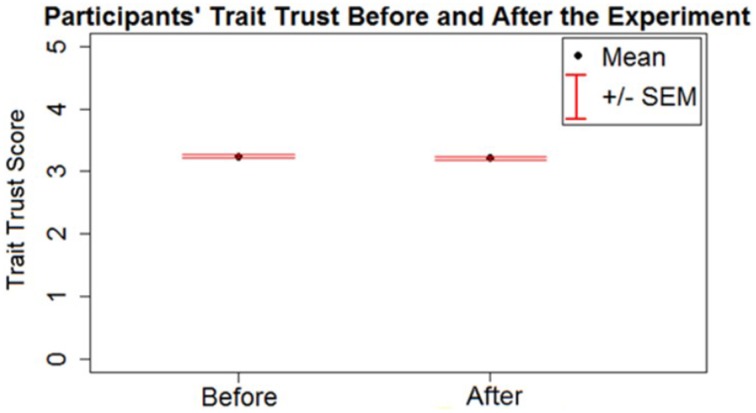
Trait trust measured before and after the experiment; the error bars represent standard error of the mean.